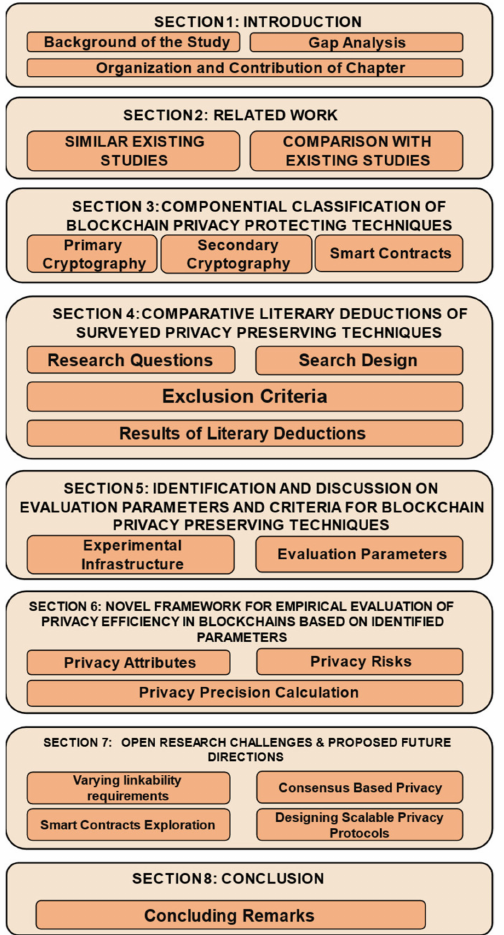
Figure 1. Organization of the